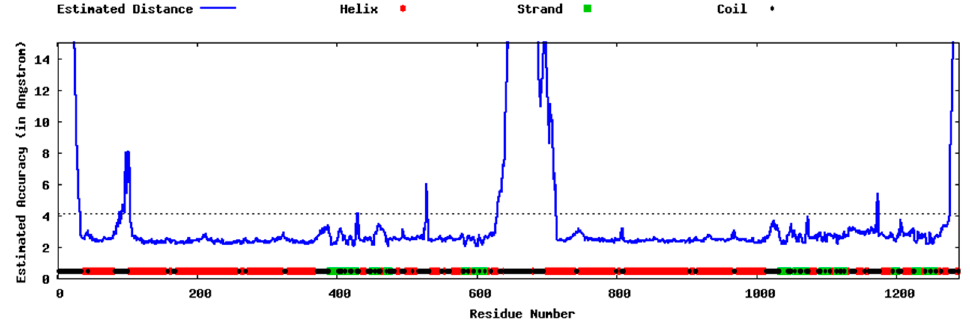
Figure 3. Local structure error profile of the Model 1 generated by the I-TASSER tool.